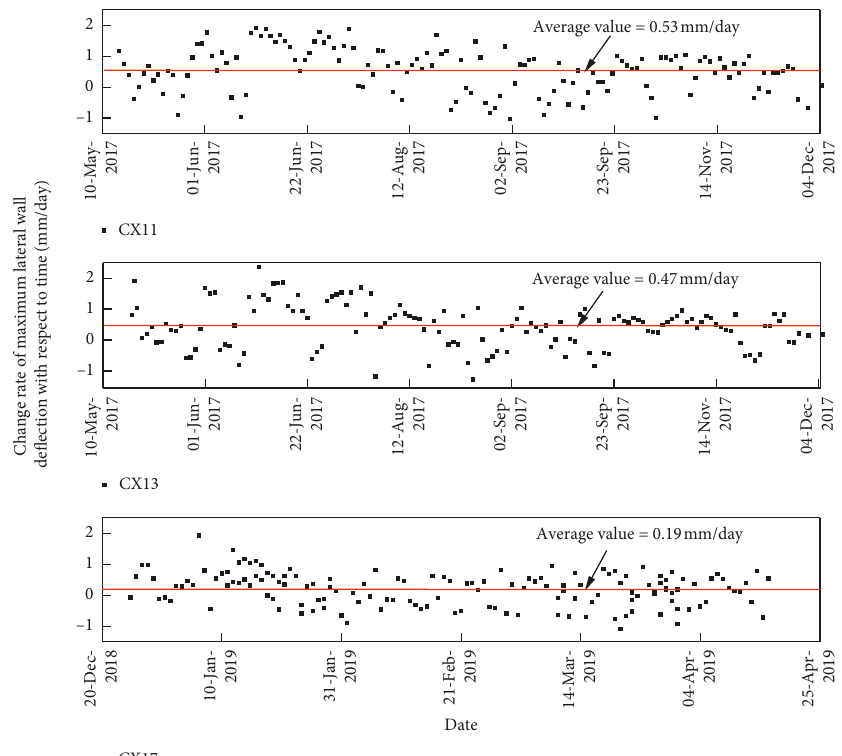
Figure 11: Change in the rate of maximum lateral wall deflection with respect to